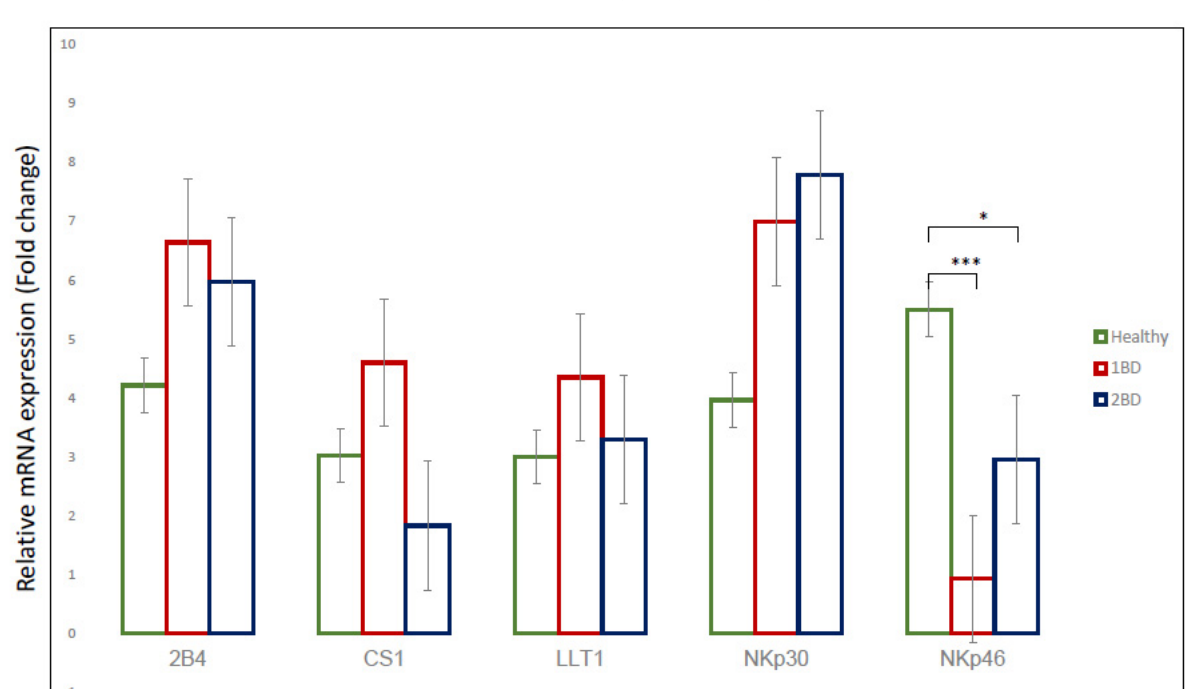
Figure 2. mRNA expression of 2B4, CS1, LLT1, NKp30 and NKp46 in ALL subjects . qRT–PCR data indicating mRNA expression of immune receptors from PBMC isolated from ALL subjects’ blood pre– and post–induction chemotherapy compared to healthy subjects. 1BD, first blood draw indi- cates sample obtained at diagnosis (day 0). 2BD, second blood draw indicates sample obtained at the end of induction chemotherapy (day 29). * p < 0.05, *** p <